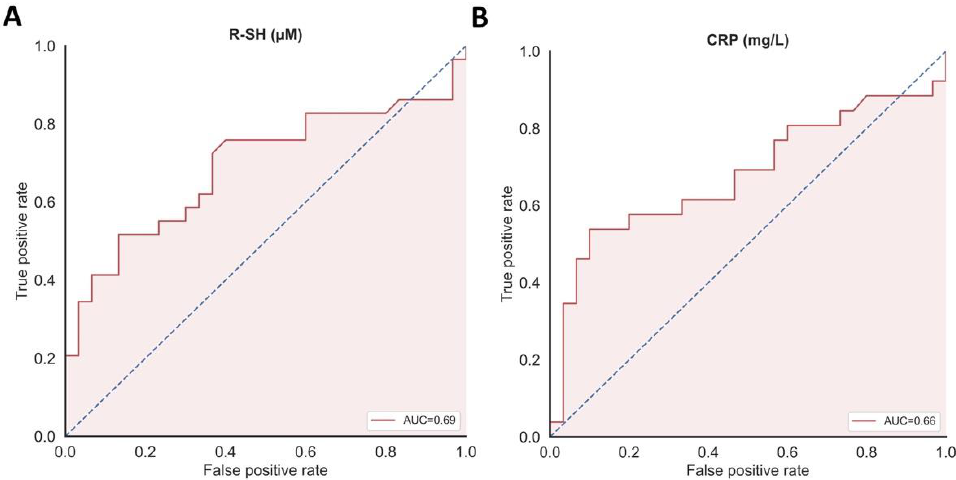
Figure 3. ( A ) Serum concentrations of free thiols ( µ M) significantly discriminated between patients with COVID-19 and healthy controls and ( B ) showing a slightly higher discriminative capacity as compared to CRP concentrations